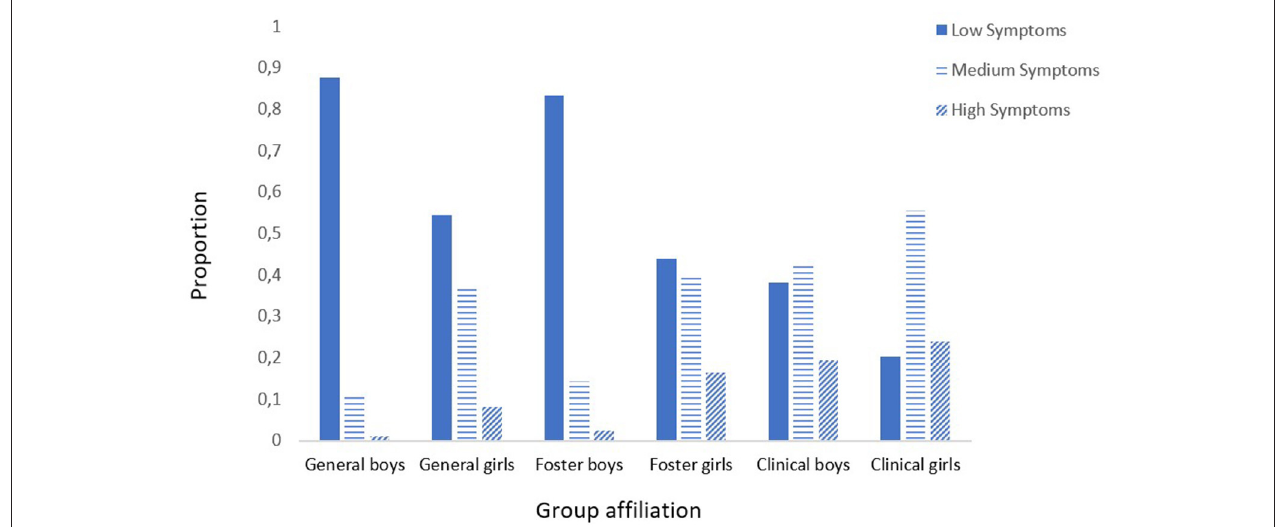
FIGURE 4 | Proportion of boys and girls in the foster care sample ( n = 245), the clinical sample ( n = 107), and the general population youth sample ( n = 1,653) and the estimated distribution into low, medium, and high symptom profiles. The figure shows the proportion of girls and boys in the foster care, clinical, and general population youth sample estimated to belong to the three-symptom profile. The figure is based on the interaction analysis between sex and the clinical youth sample. The analysis was controlled for the mean age for all three samples.